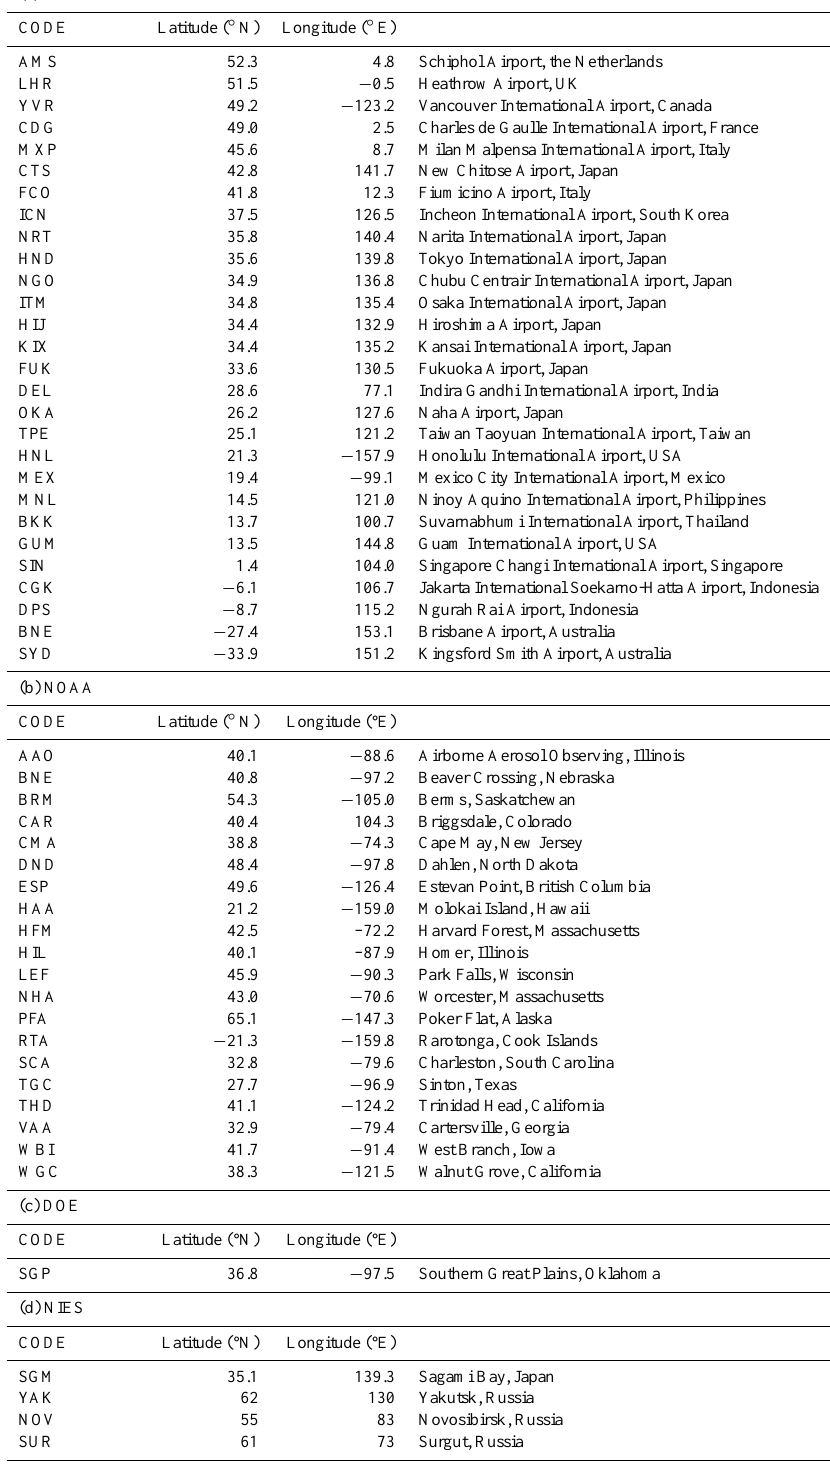
Table 1. Locations of the sites where aircraft measurements were